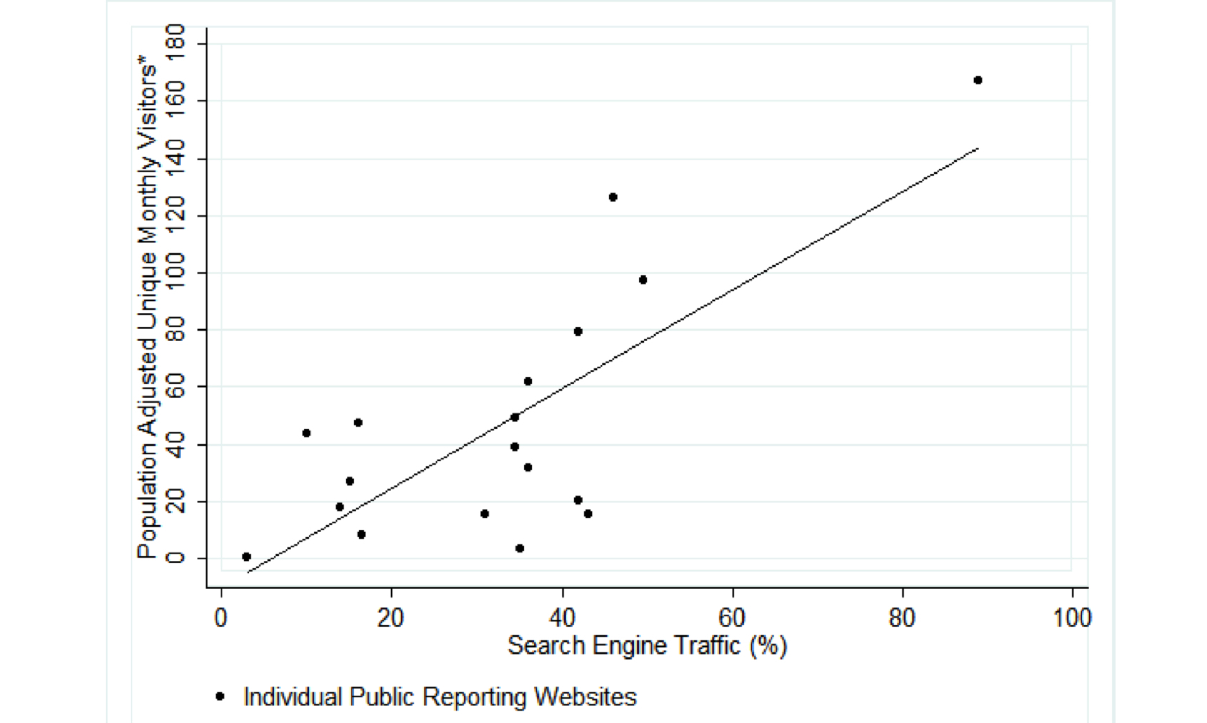
Figure 1. Relationship between proportion of traffic from search engines and population-adjusted number of unique monthly visitors to public reporting websites of hospital and outpatient provider quality. *This is the per capita traffic: the number of unique monthly visitors per 100,000 Internet-using households in the catchment area of the individual public reporting